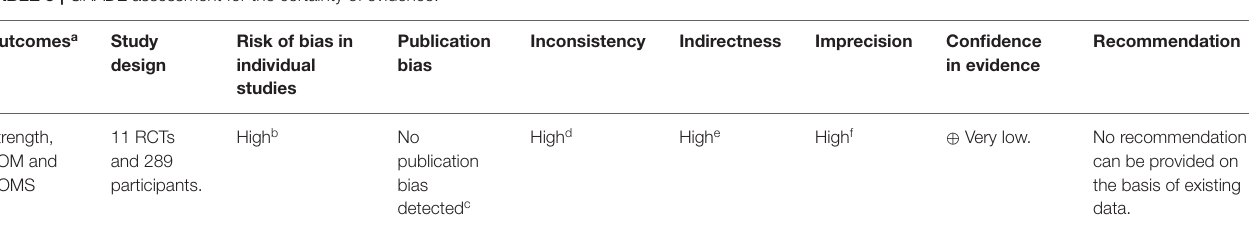
TABLE 5 | GRADE assessment for the certainty of